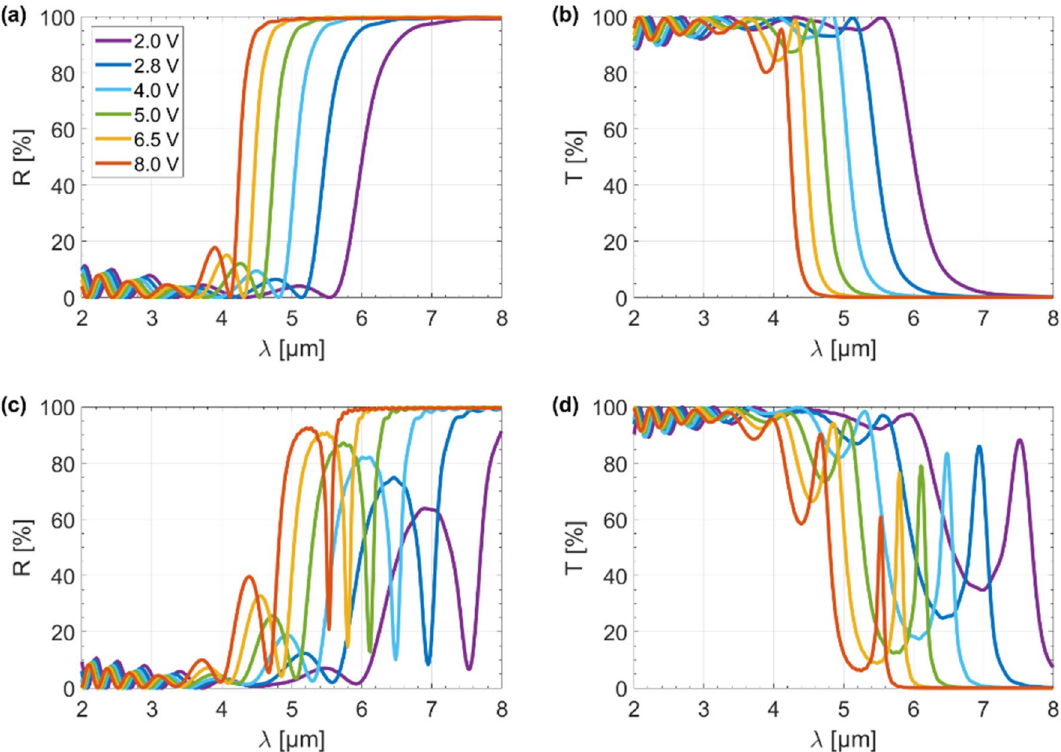
Figure 4. Reflection ( a ) and transmission ( b ) spectra for the unmodulated structure, and reflection ( c ) and transmission ( d ) spectra for the modulated structure as a function of gate voltage ( V g